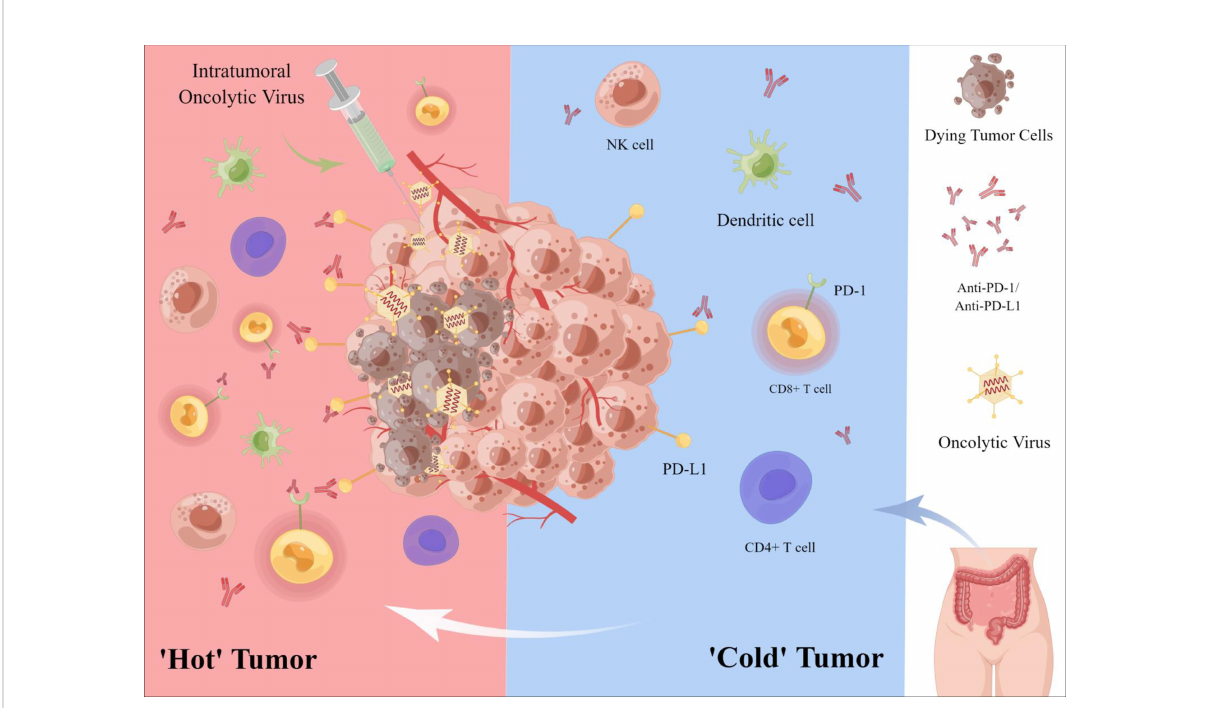
FIGURE 2 Oncolytic virus combined with immune checkpoint inhibitor in the treatment of colorectal cancer. OVs, lyse tumor cells while attracting immune cells (e.g., CD8+ T cells, NK cells) to the tumor microenvironment, thus transforming a ‘ cold ’’ tumor into a ‘ hot ’’ one to enhance the sensitivity of tumor cells to ICIs. In addition, OVs can enhance the targeted therapeutic effect of PD-1/PD-L1 inhibitors by up-regulating the expression of tumor cell immune checkpoint